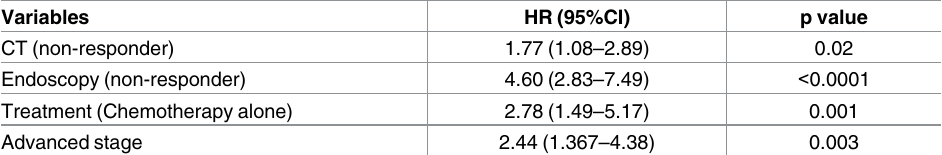
Table 3. Multivariate survival analysis using Cox’s regression model for adjustment of clinicopatho- logical factors.